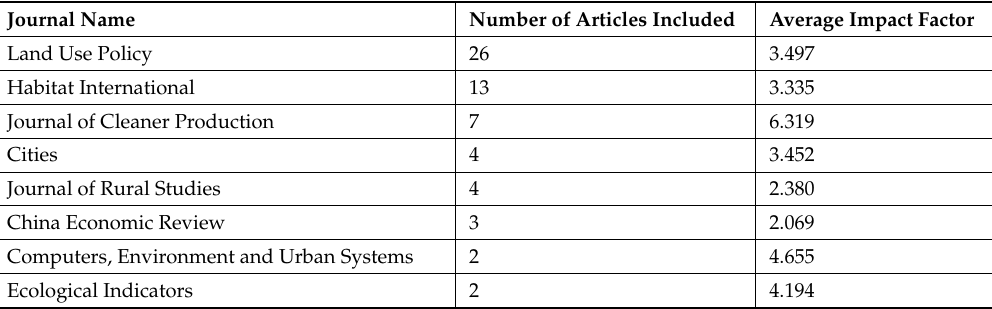
Table A1. Journal information of the selected 72